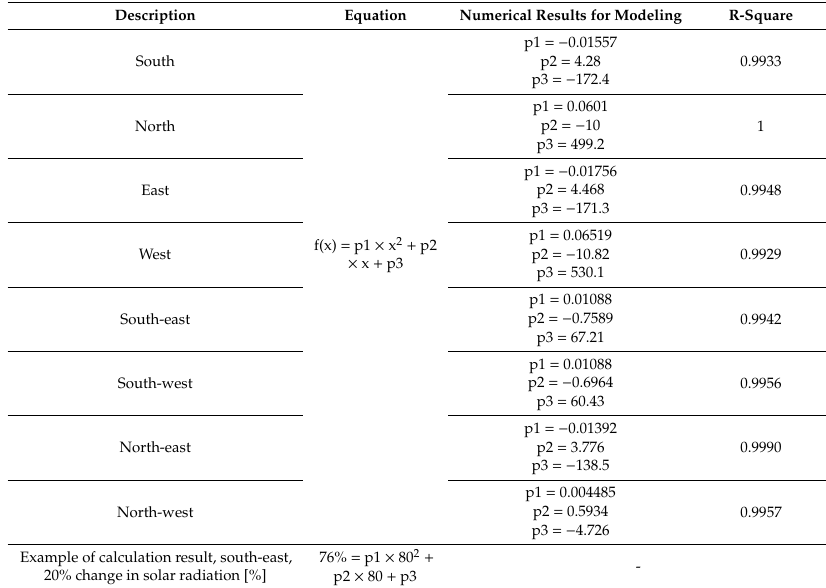
Table 5. The e ff ect of solar radiation changes on a-Si performance (x = change in solar radiation (%), FP = 100%, 80% = 20% change in solar radiation; f(x) = percentage value of the performance compared to the FP).